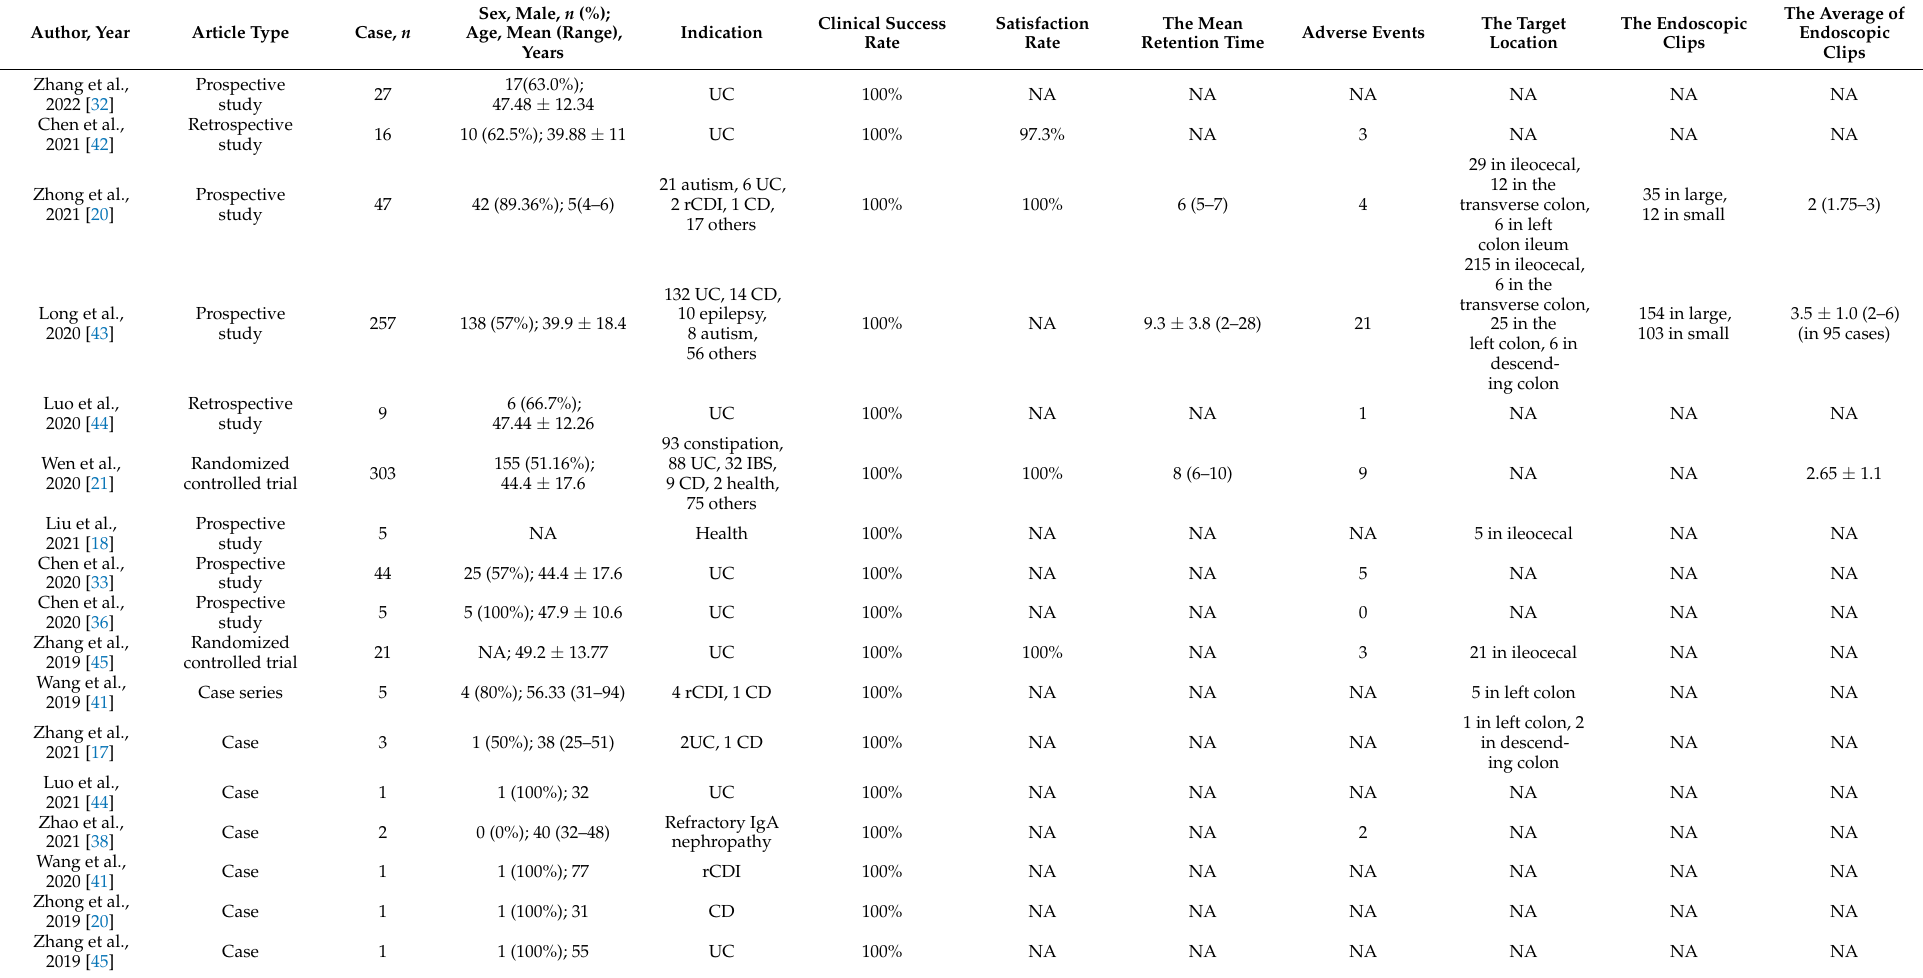
Table 2. The reported indications, clinical success rates, satisfaction rates, and adverse events of colonic